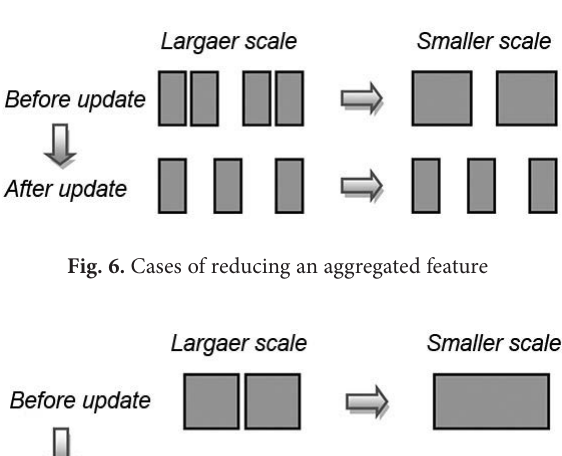
Fig. 5. Cases of enlarging an aggregated feature